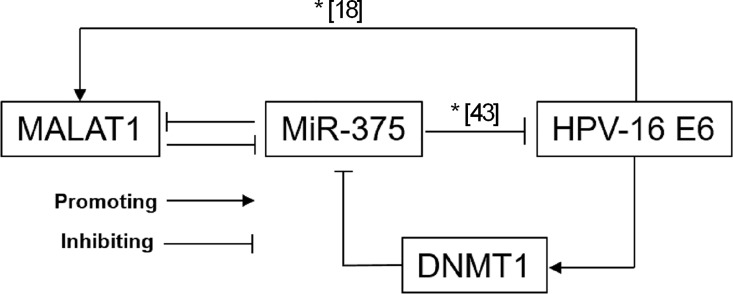
Schematic diagram of the regulative networks among MALAT1, miR-375, HPV-16 E6 and DNMT1 in cervical cancer cells.* Inhibition of E6 by miR-375 and the enhancing effect of E6 on MALAT1 expression were from previously published data.